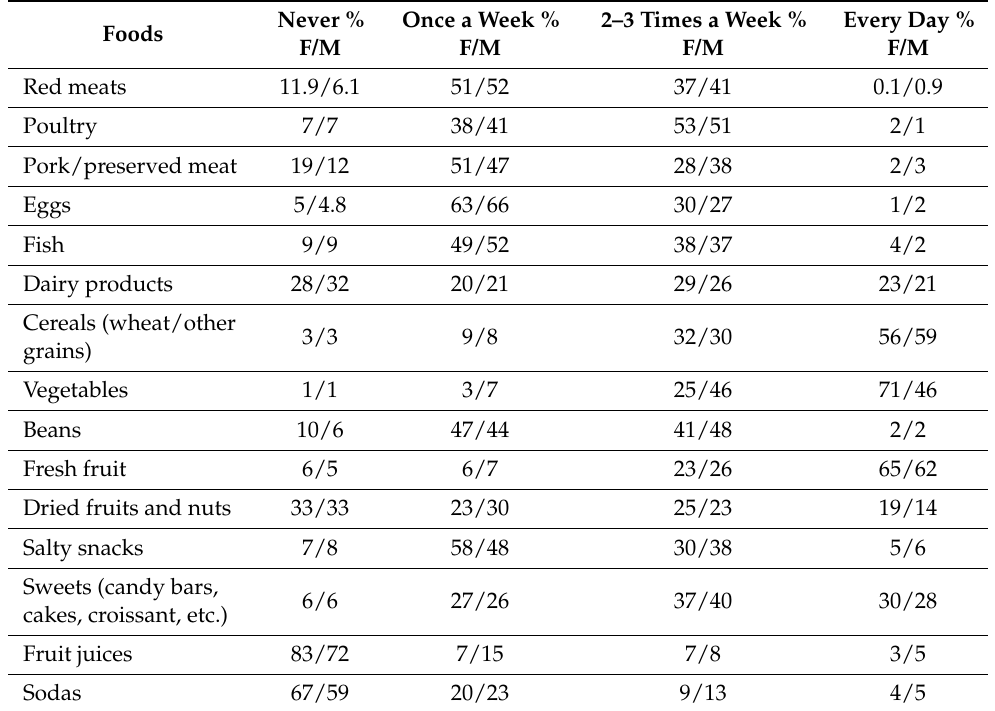
Table 4. The reported weekly intake of specific foods. (F: Female; M: